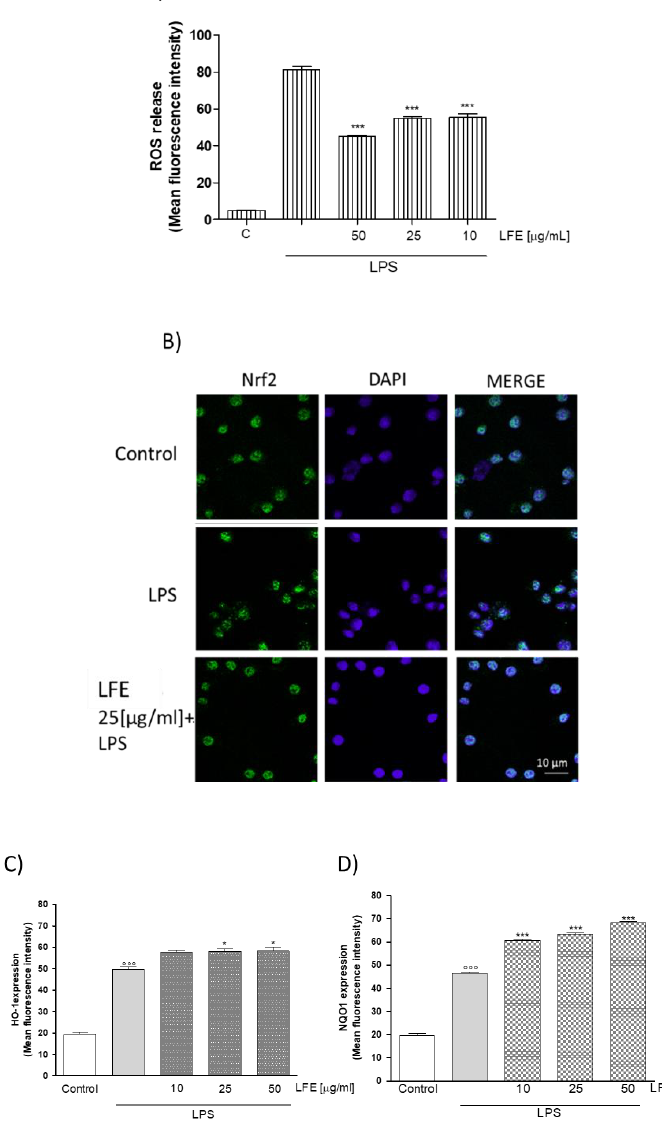
Figure 4. Effect of LFE (10–50 µ g mL − 1 ) on LPS-induced reactive oxygen species (ROS) in LPS-stimulated J774A.1 macrophages (Panel A). Effect of LFE (25 µ g mL − 1 ) on NF-E2-related factor-2 (Nrf-2) (Nrf2) nuclear translocation in J774A.1 macrophages (Panel B). Nuclear translocation of Nrf2 was detected using immunofluorescence assay at confocal microscopy. Scale bar, 10 µm. Blue and green fluorescence indicates localization of nucleus (DAPI) and Nrf2, respectively. Analysis was performed by confocal laser scanning microscopy. Effect of LFE (25 μg mL −1 ) on LPS-induced heme oxygenase- 1 (HO-1) (Panel C) and on NAD(P)H quinone dehydrogenase 1 (NQO1) (Panel D) in macrophages J774A.1. Values are expressed as mean ± s.e.m of at least three experiments, each in triplicate. Comparisons were performed using one-way analysis of variance and multiple comparisons were